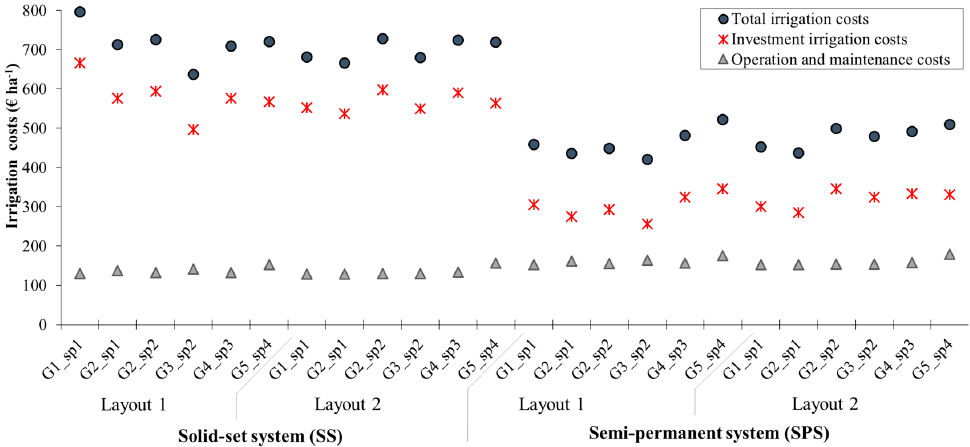
Figure 7. Comparing solid set and semi-permanent sprinkler system alternatives for total, investment and operation and maintenance irrigation costs ( € · ha − 1 ). Layouts are defined in Figure 4, while sprinkler spacing (G1, 2, . . . , 5) and sprinkler types (sp1, 2, . . . , 4) are identified in Table